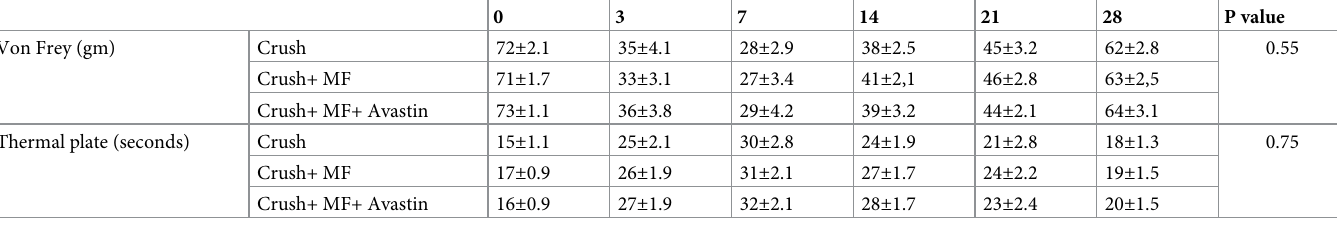
Table 3. Outcome of von Frey and thermal plate in different treatment groups related to various time frames.